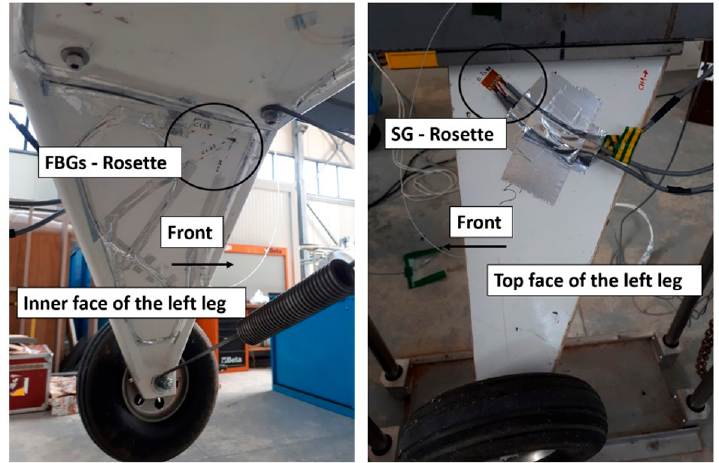
Figure 9. Inner face of the left leg with the FBG rosette ( right ); top face of the left leg with SG rosette ( left ).